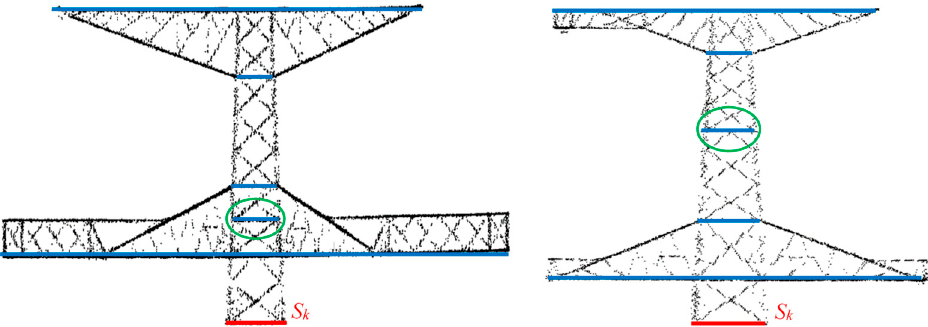
Figure 10. The relation between the segmentation positions with the boundaries of complex